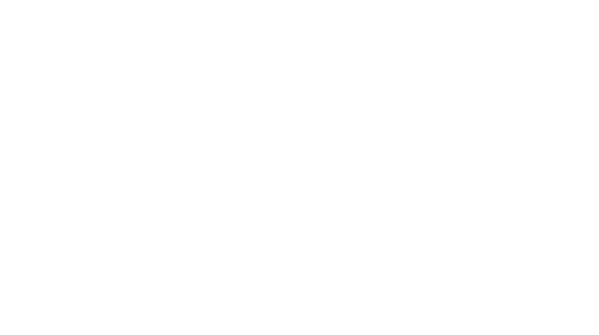
Figure 9. The fracture surface scheme, where A, B, and C are the sites of the observation